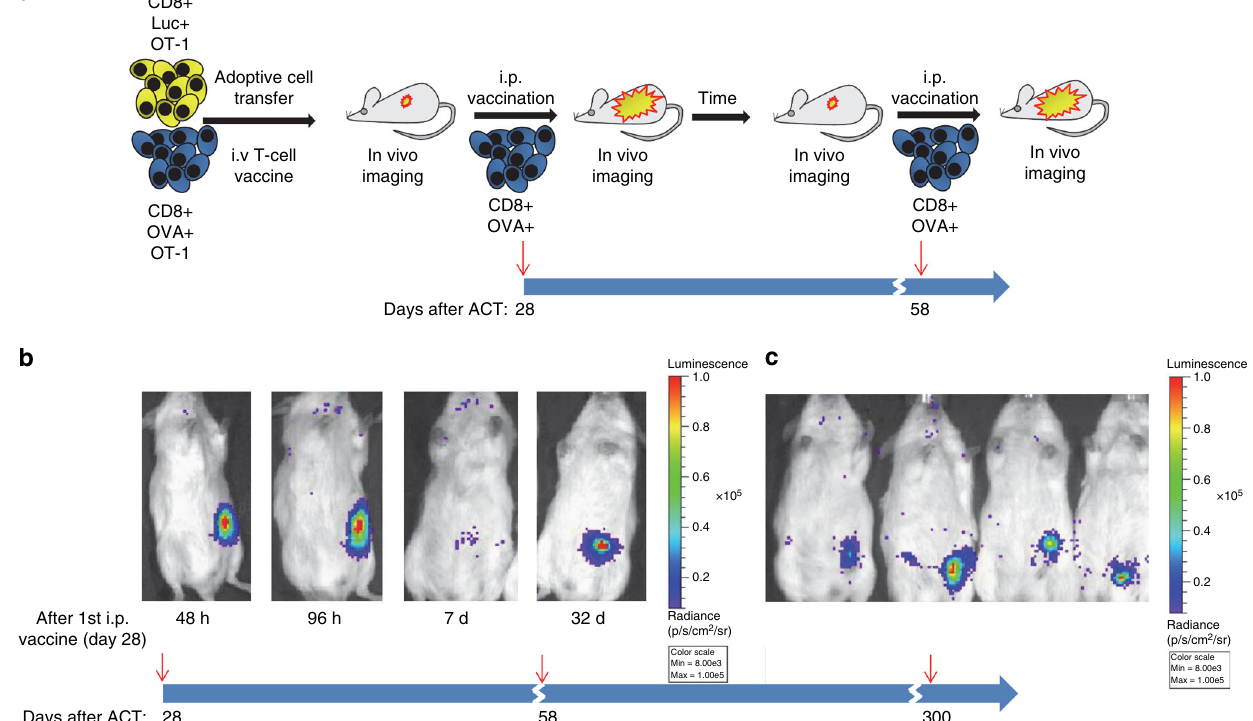
Fig. 4 Cellular vaccine supports effective boosting and re-boosting. a Schematic representation of experimental protocol assessing cellular vaccine ef fi cacy. b i.p. booster vaccines were administered to mice receiving transfer of 1 × 10 7 pT-ef fl uc-thy1.1-modi fi ed CD8 + T cells. The blue timeline arrow indicates the days after ACT. Red arrows indicate i.p. cellular vaccine administration on days 28, 58, and 298. A representative image ( a – c ) corresponds to the blue arrow timeline ( N = 5). c Effective boosting by i.p. T-cell vaccine was observed 300 days (image, c , shown are four of the fi ve mice) after ACT of 1 × 10 7 pT-ef fl uc-thy1.1-modi fi ed cells co-administered with the i.v. OVA + OT-1 T-cell